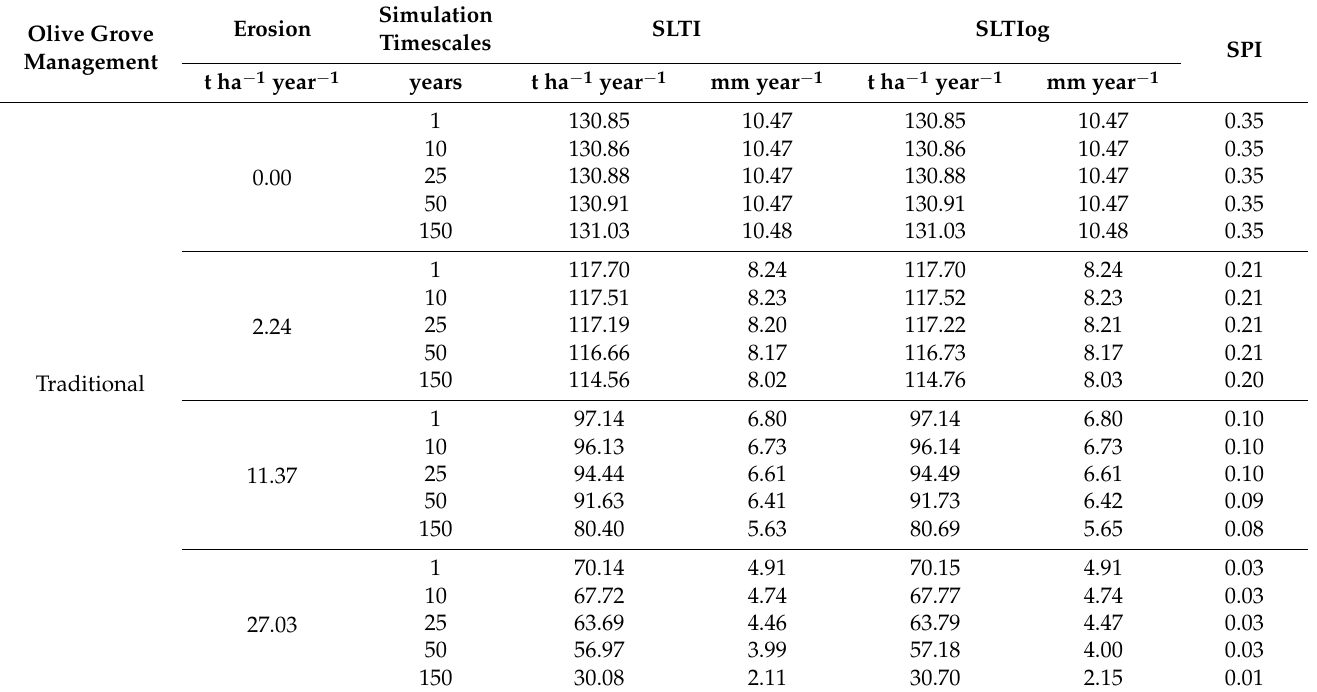
Table 5. Soil Loss Tolerance Index (SLTI), Soil Loss Tolerance Index for olive groves (SLTIog), and Soil Productivity Index (SPI) for the PDO Norte Alentejano, taking into account the implementation of drip irrigation in all treatments. If in any of the simulations the value of any of the indices is zero (0), it is considered to be an unsustainable situation (US). Olive Grove